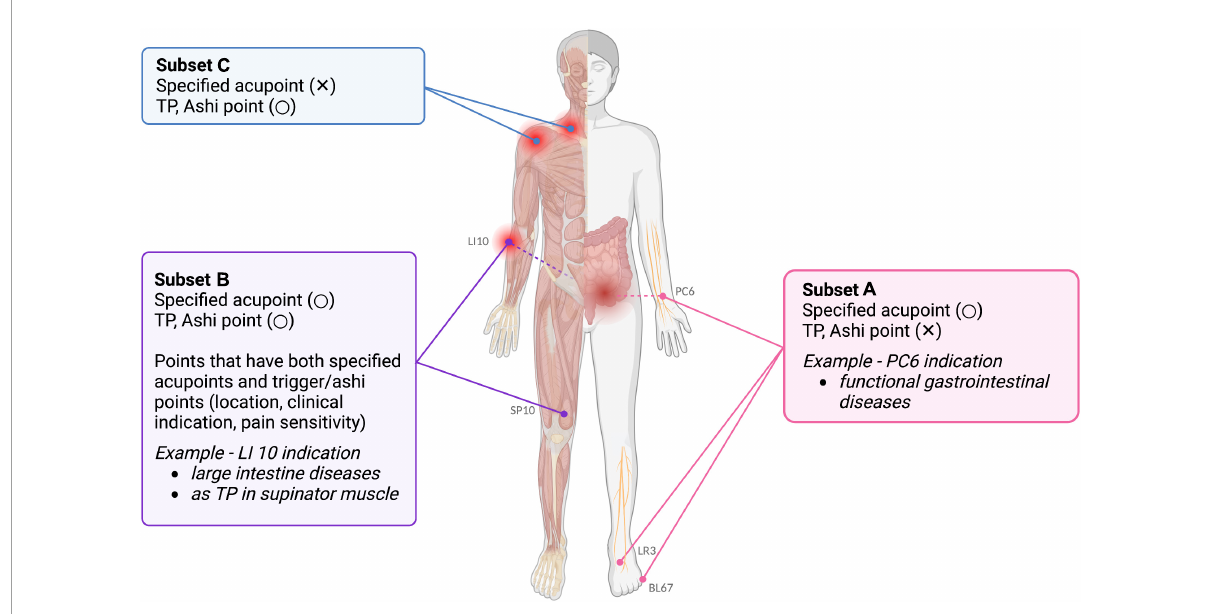
FIGURE2 Examples of subsets A, B, and C on a human body template. Subset A consists of specified acupoints, but not TPs or Ashi points. Neurovascular bundles, comprising A and C fibers, are concentrated at these places. For instance, acupoint PC6 is known to treat functional gastrointestinal diseases. Subset B includes areas with common features of specified acupoints, TPs, and Ashi points. These common features include similar locations, clinical indications, and pain sensitivity. For example, acupoint LI10 in the large intestine meridian can treat diseases of the large intestine, while it can serve as TP of the supraspinatus muscle. Subset C comprises points that are not defined as specified acupoints, but are TPs or Ashi points. Muscles and fasciae are the main targets of subset B and C treatment. The image was created using BioRender